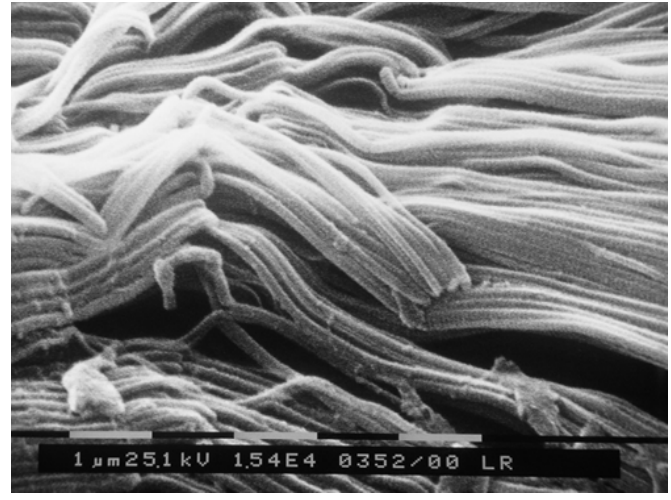
FIGURE 10. SEM image of longitudinally sectioned rat patellar tendon. Single collagen fibrils run parallel showing a D-period banding and have a bimodal-plurimodal diameter. Note fibrils suddenly changing direction, bending and appearing partially squeezed in knots. Bar = 1 μ